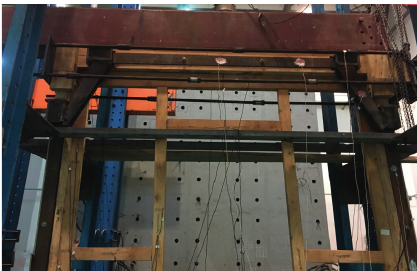
Figure 3: Channel steel and the diagonal brace.